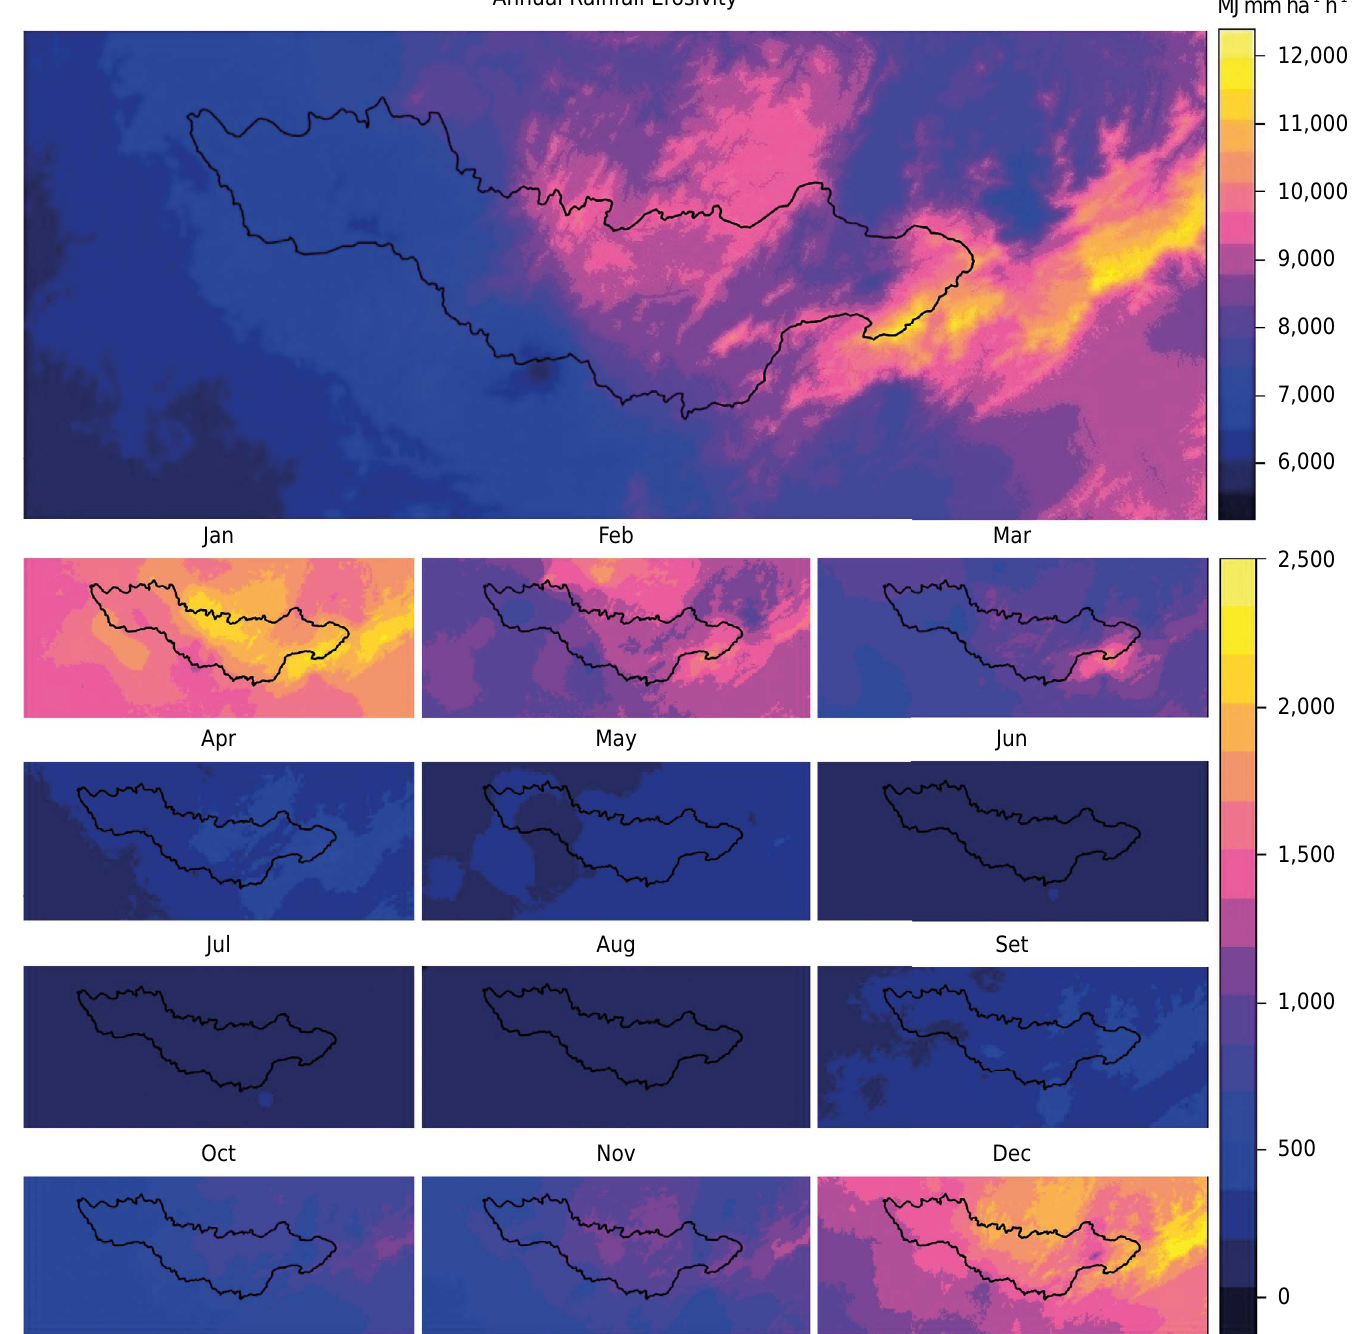
Figure 4. The EI 30 maps (MJ mm ha -1 h -1 ) for annual e monthly erosivity obtained with regression kriging in the Jaguarí River